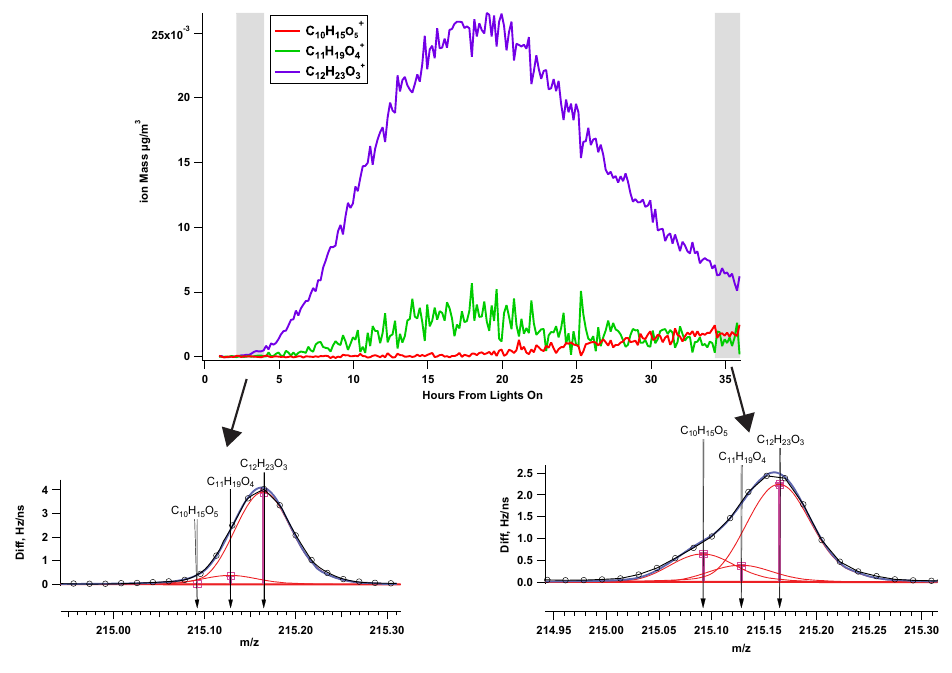
Fig. 4. Time series of ions and the raw data for “early growth” and “most oxidized growth” for m/z 215.